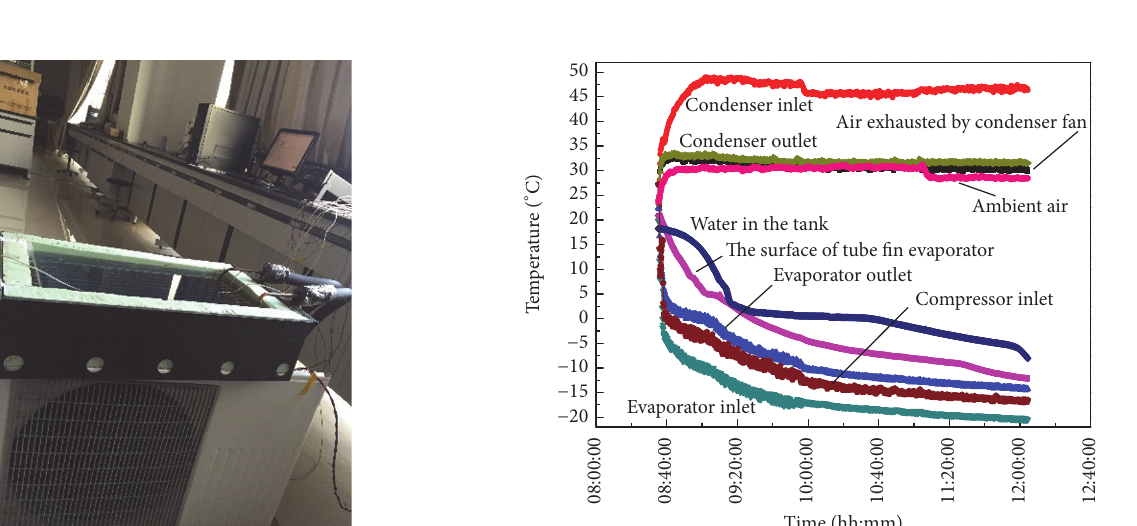
Figure 17: Top view of cointegration evaporators and cold exchanger immersed in the ice storage tank.